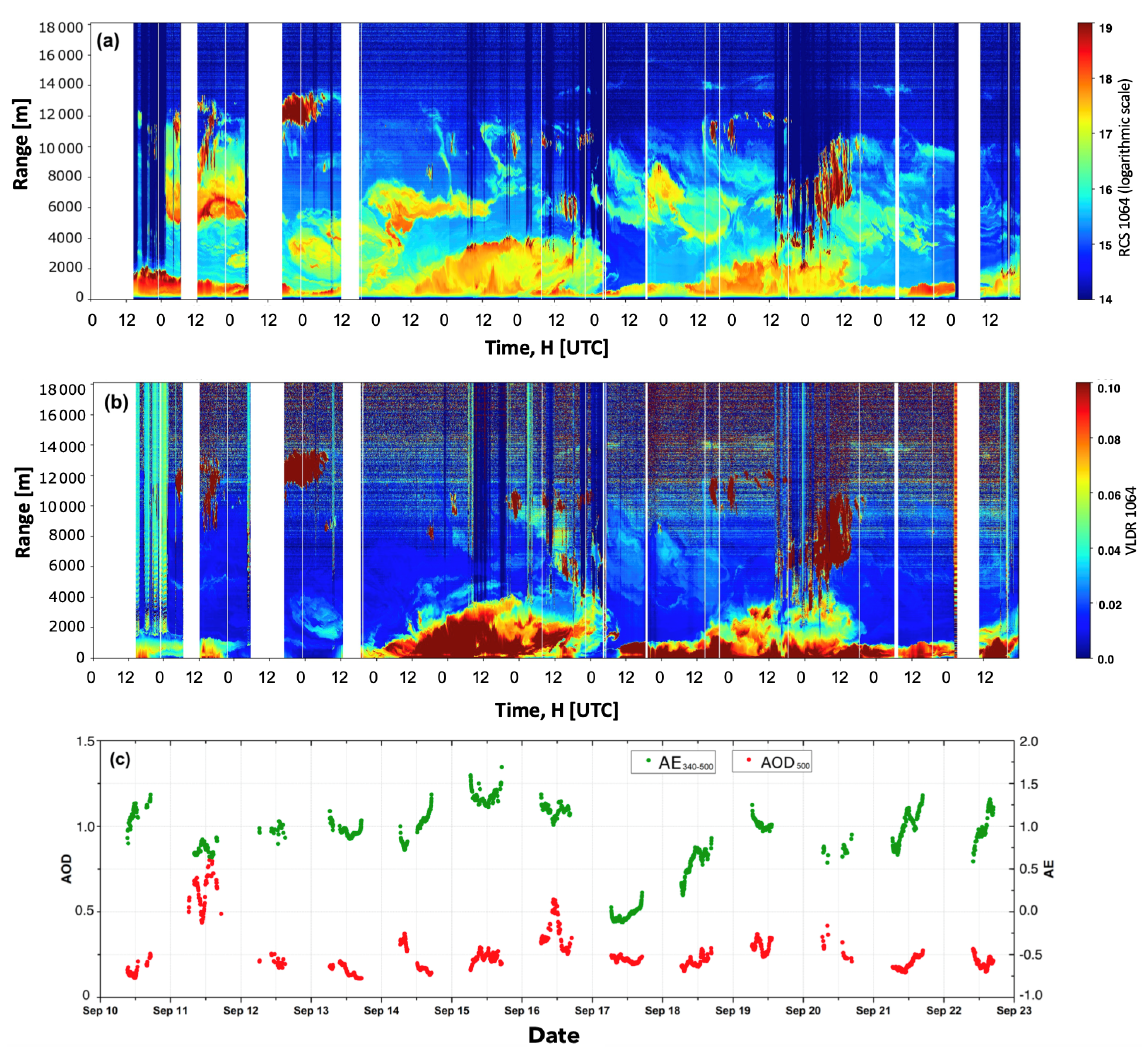
Figure 4. Lidar and sun/sky photometer observations during the smoke episodes on 10–22 September 2020, ATOLL, France. (a) The range corrected lidar signal at 1064nm. (b) The volume depolarization ratio at 1064nm. (c) The AOD and AE measured by the sun/sky photometer operated at ATOLL. The layers with strong depolarization appearing in the boundary layer on 14–16 September are polluted dust from the Saharan region. The smoke layers from Californian smoke are mostly distributed in the free